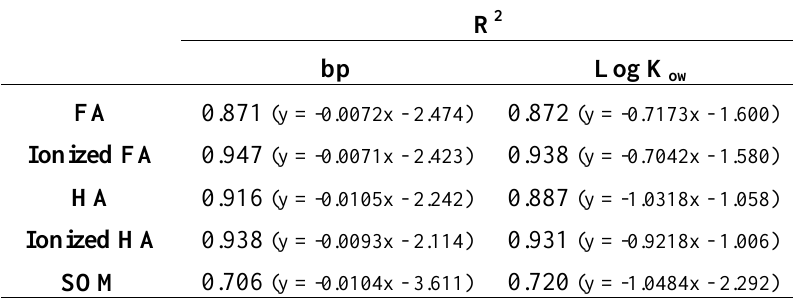
Table 3. Statistical correlations between two chemical properties (bp and Log K final docked energy of PAHs.